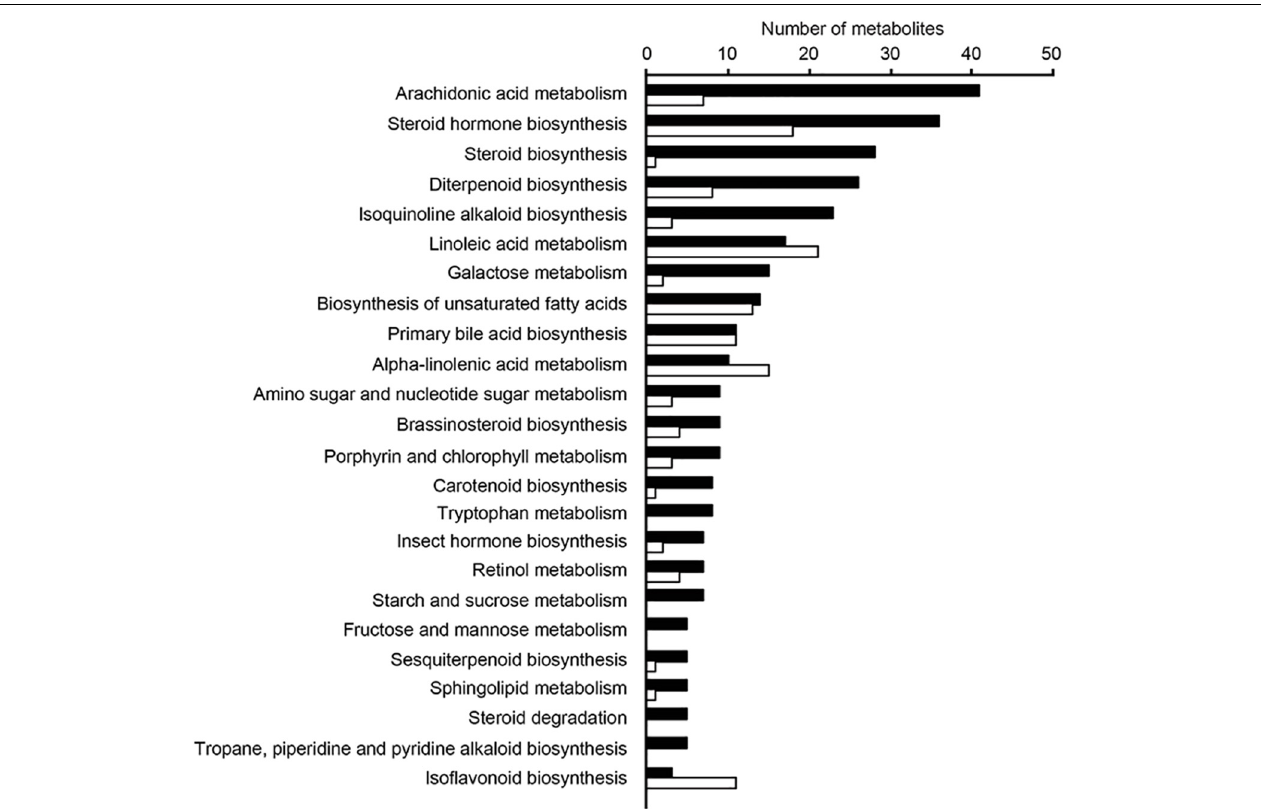
FIGURE 6 | Pathways with differences in metabolite levels between the Amazon and Rio de Janeiro sample groups. Ions showing differences of at least 2-fold in relative intensity values between these groups were assigned to KEGG pathways using the Pathos online software. This was done for both positive (black bars) and negative (white bars) ionization data. Bars represent the number of assigned metabolites in each pathway. Only pathways that had at least 5 assigned ions are